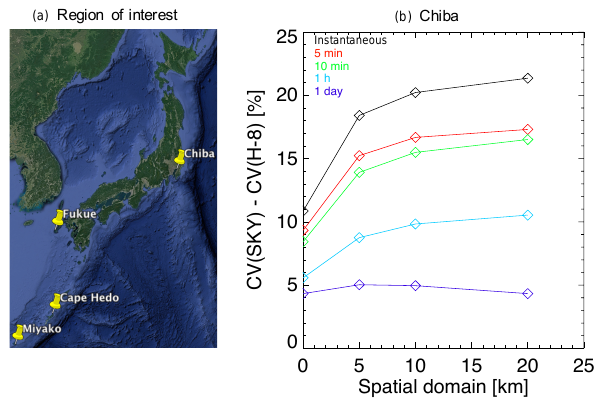
Figure 1. (a) Region of interest showing the four SKYNET stations used in the validation of Himawari-8 estimates of global radiation. Source: Google Earth Pro. (b) Difference in the coefficient of vari- ation (CV) of global radiation values obtained by SKYNET (SKY) and Himawari-8 (H-8) and in the size of the domain for different time averages (instantaneous time resolution: 2.5min). Period: Au- gust 2016; station: Chiba. See text for further details.